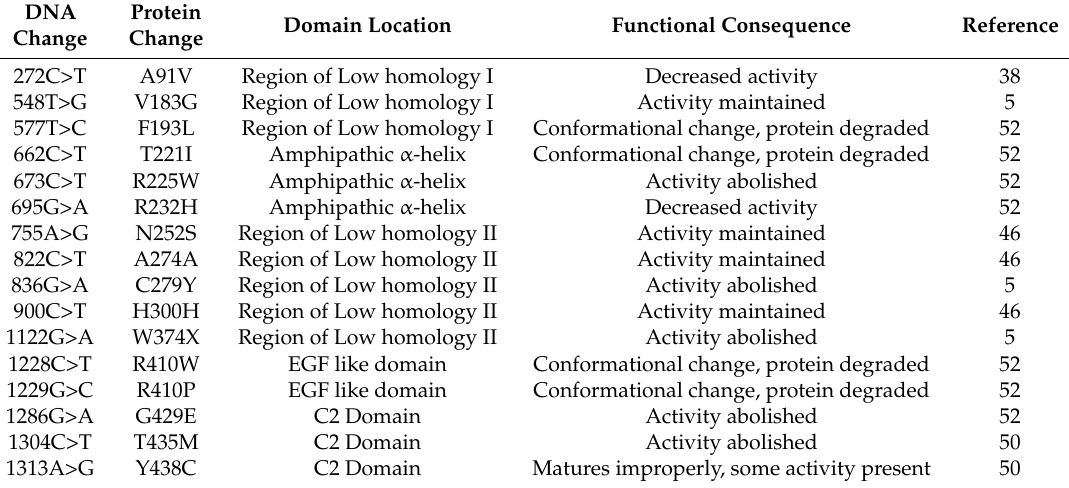
Table 1. List of selected PRF1 single nucleotide variants (SNVs). Polymorphisms shown have had activity tested by other research groups. For each SNV listed, the resulting protein change and functional consequence is listed. All listed SNVs have been identified in FHL 2* patients, however this list is not